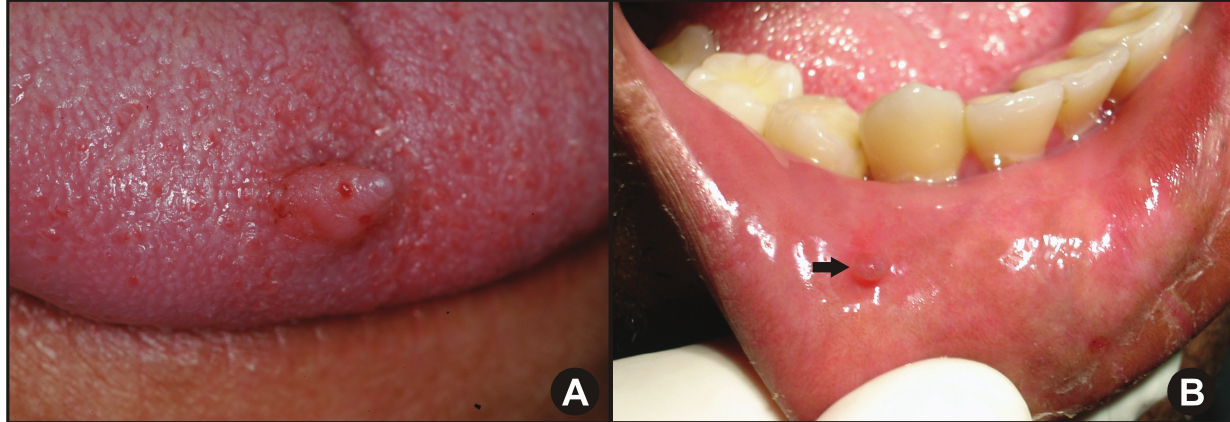
Figure 1 - A (Case 1) - A sessile nodule covered by filiform and erythematous fungiform papillae, located on the lingual apex. B (Case 2) - A small pe- diculadum nodule in the lower lip (black arrow)